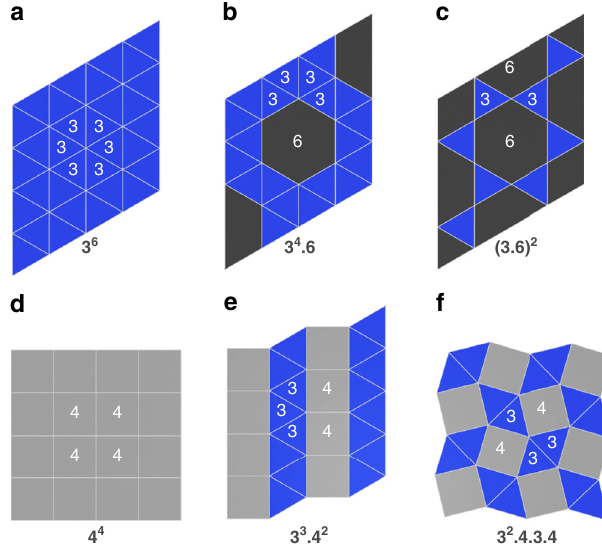
Fig. 1 Archimedean tessellations. Six of the 11 regular ( a , d ) and semi- regular ( b , c , e , f ) Archimedean tessellations of the Euclidean plane: a triangular, b snub hexagonal, c trihexagonal (kagomé), d square, e elongated triangular, and f snub square